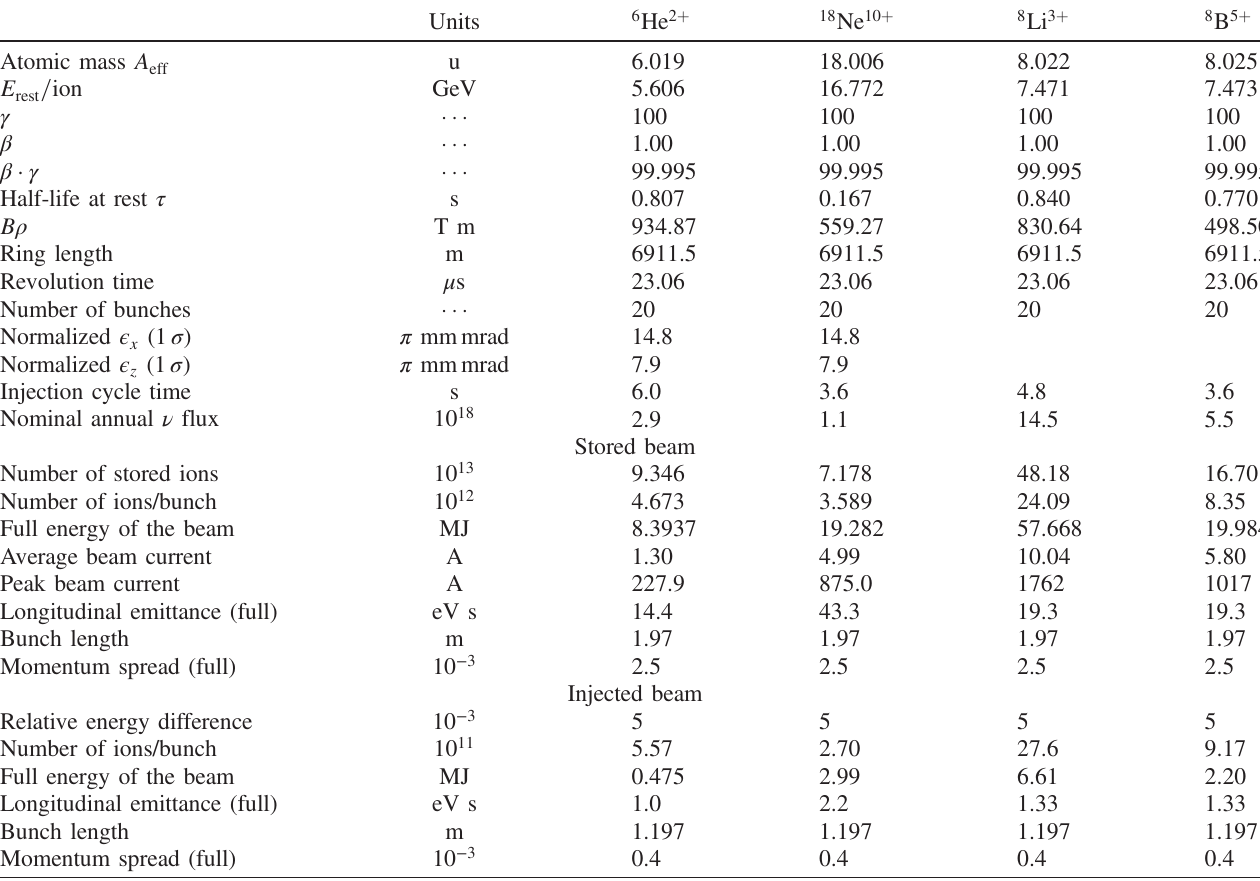
TABLE VIII. Beam parameters.